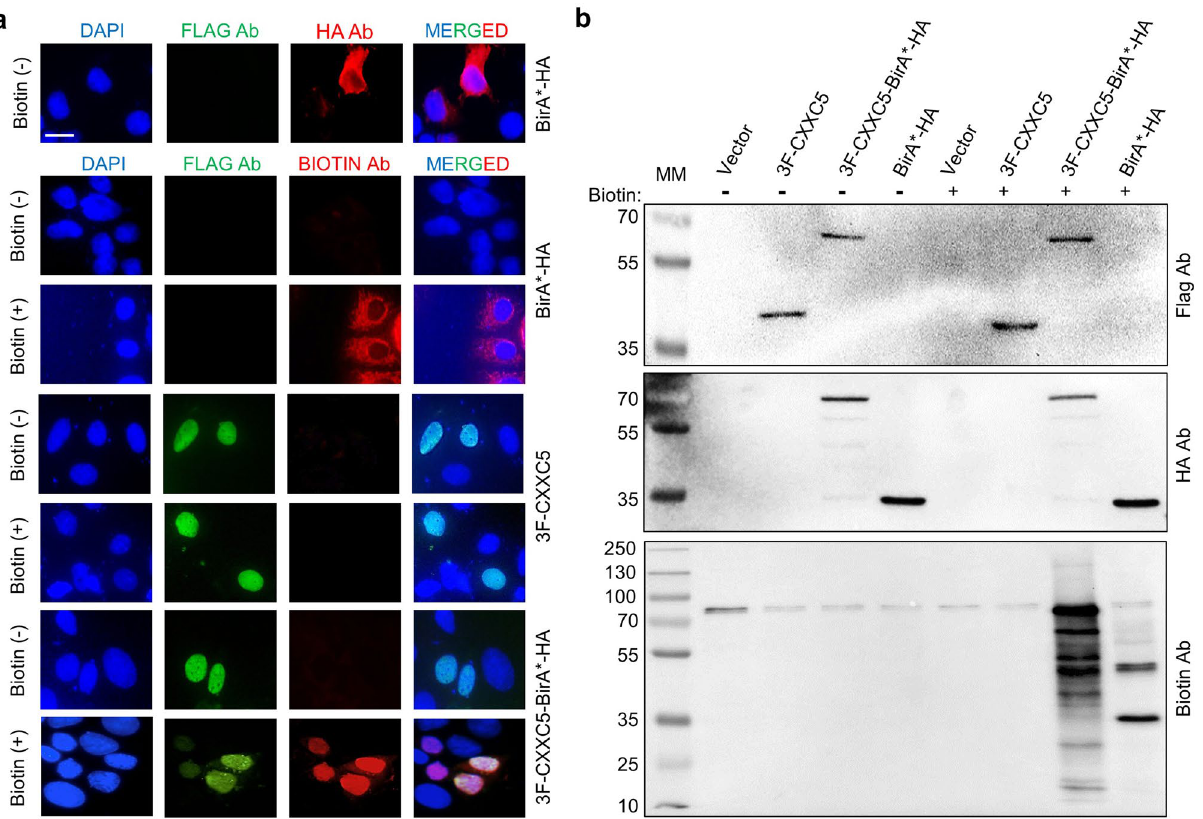
Figure 1. Biotinylation of endogenous proteins in MCF7 cells. MCF7 cells were transiently transfected for 24 h with an expression vector (pcDNA3.1) bearing the cDNA for 3F-CXXC5, 3F-CXXC5-BirA*-HA, or BirA*-HA. Cells were then treated without (-) or with ( +) biotin (50 μM) and ATP (1 mM) for 16 h. ( a ) Transiently transfected cells were subjected to immunocytochemistry using the Flag, the HA, or the Biotin antibody followed by an Alexa Fluor 488 (green fluorescein) conjugated goat anti-mouse IgG for the Flag antibody, or an Alexa Fluor 594 (red fluorescein) conjugated goat anti-rabbit IgG for the HA and the Biotin antibody. The scale bar is 20 µm. ( b ) Total protein extracts of MCF7 cells were subjected to SDS-10%PAGE followed by WB using the Flag, the HA, or the Biotin antibody followed by an HRP-conjugated goat-anti mouse secondary